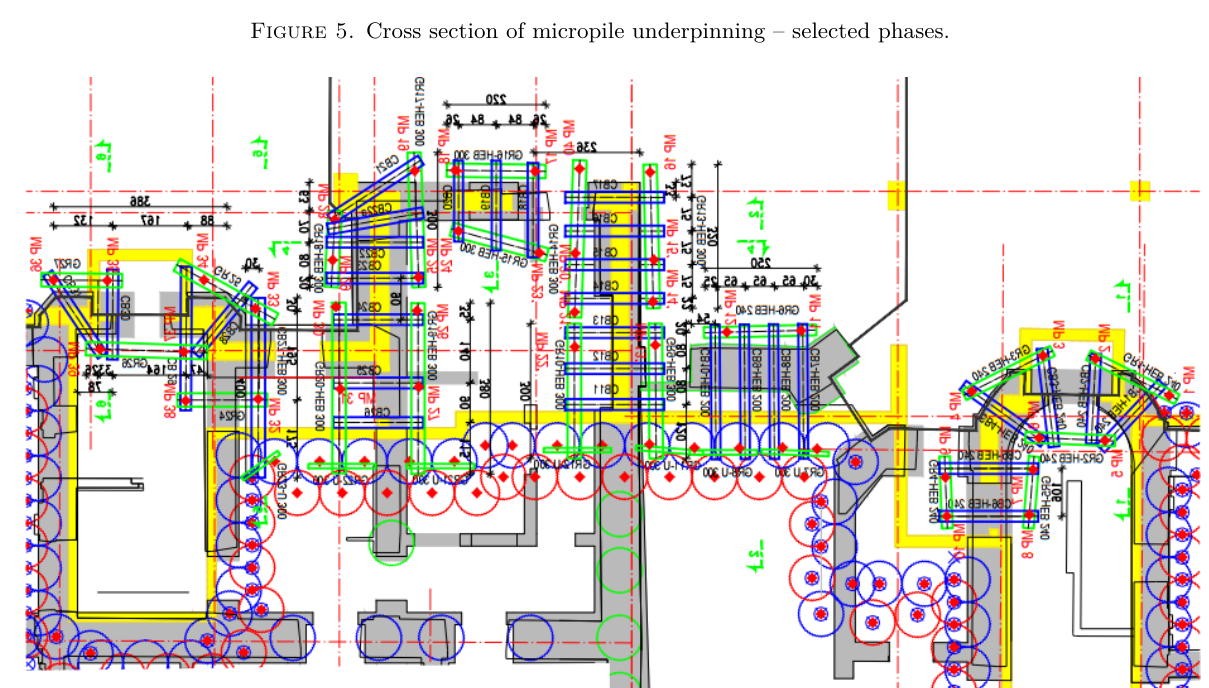
Figure 6. Layout of micropile